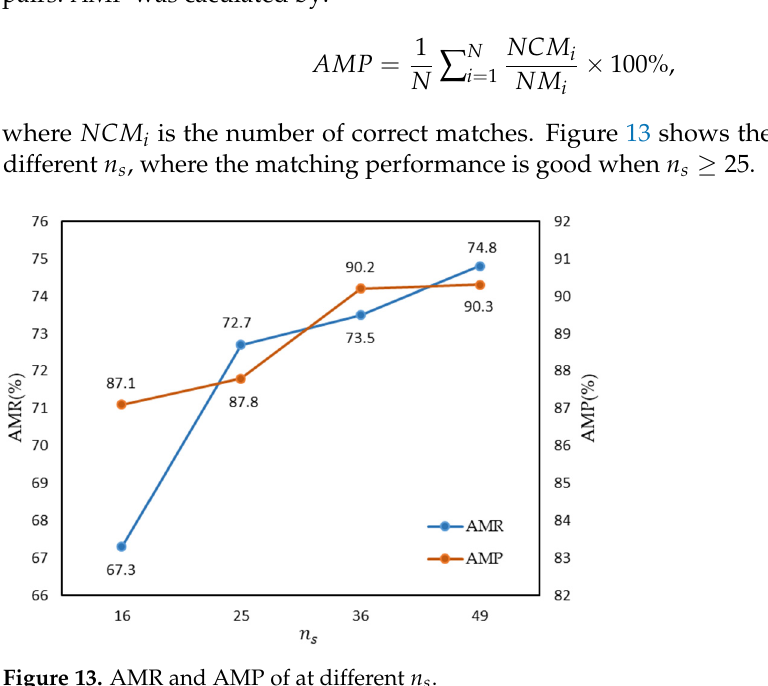
Figure 13. AMR and AMP of at different 𝑛 𝑠